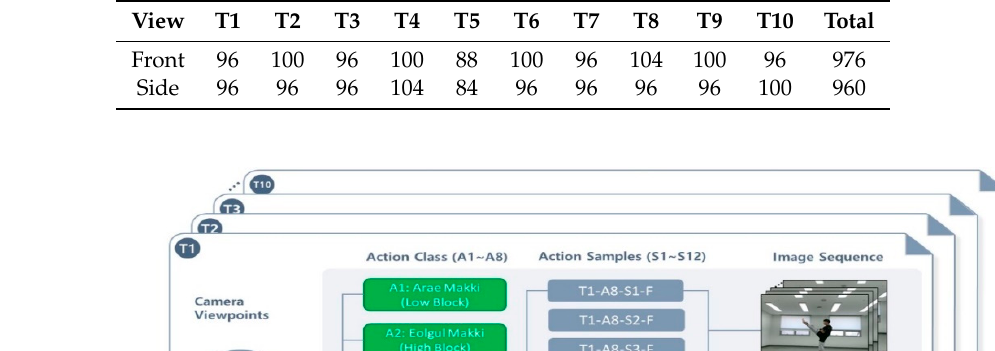
Table 1. The number of acquired action samples by subject and camera view.